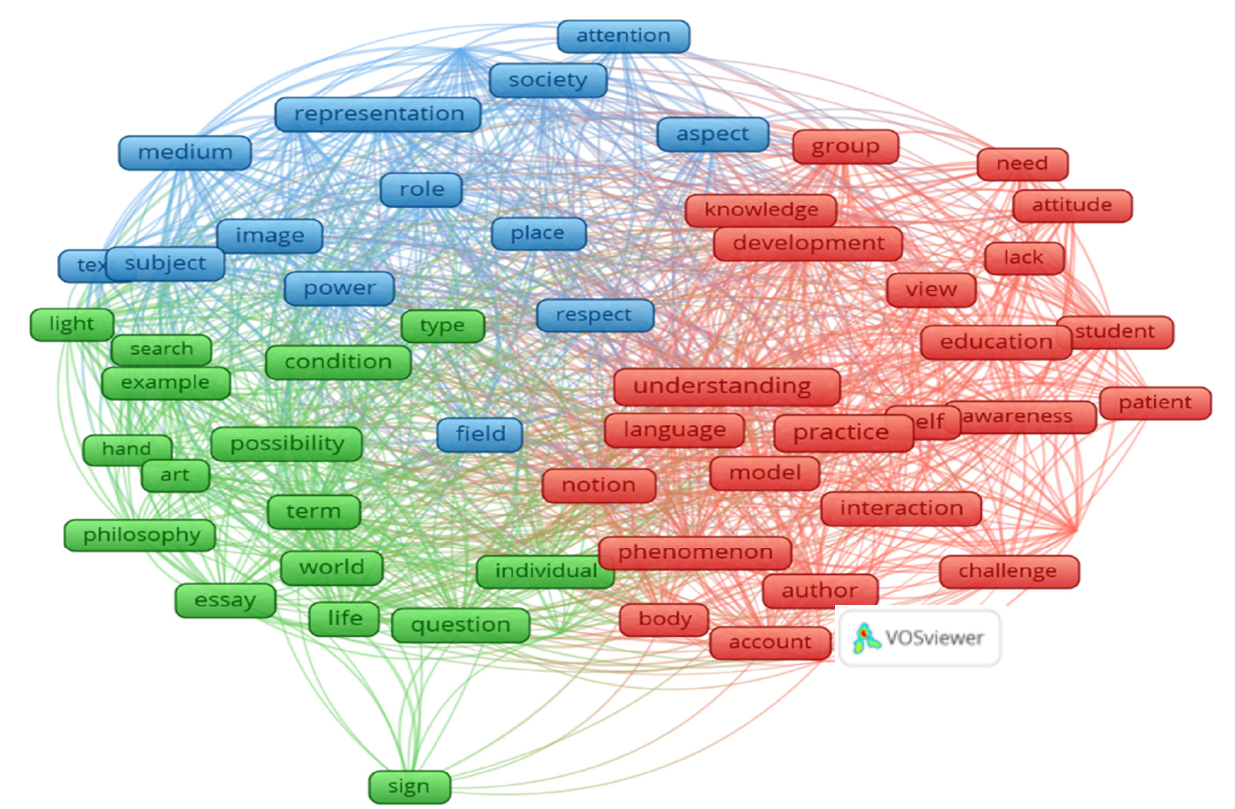
Figure 2. Themes from communication, otherness, and coexistence 2017–2021. Source: Web of science using VOSviewer.